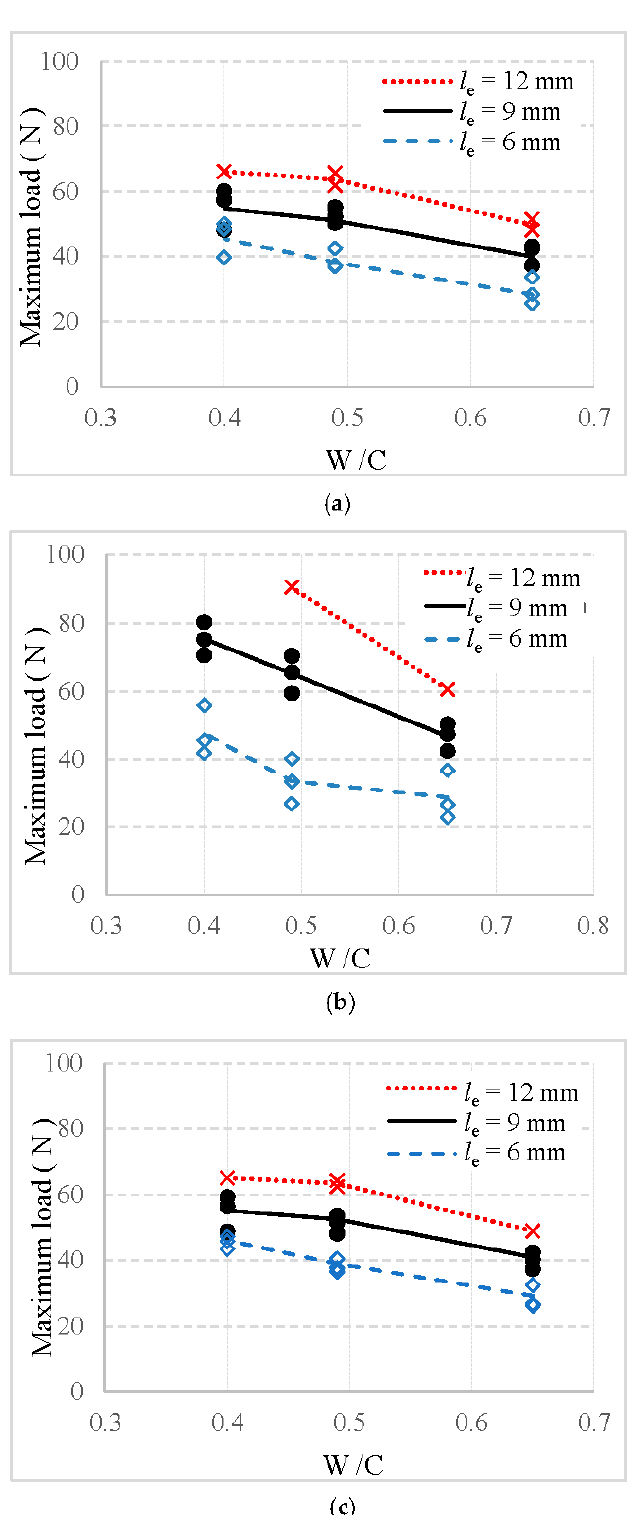
Figure 8. Maximum loads of fiber pulled out from mortar: ( a ) basalt fiber, ( b ) PVA fiber, and ( c ) glass fiber.